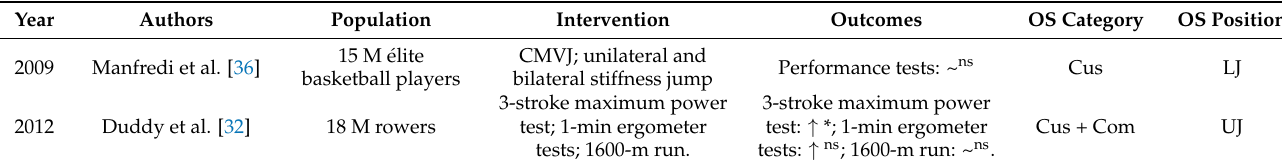
Table 2. Data extraction of the included